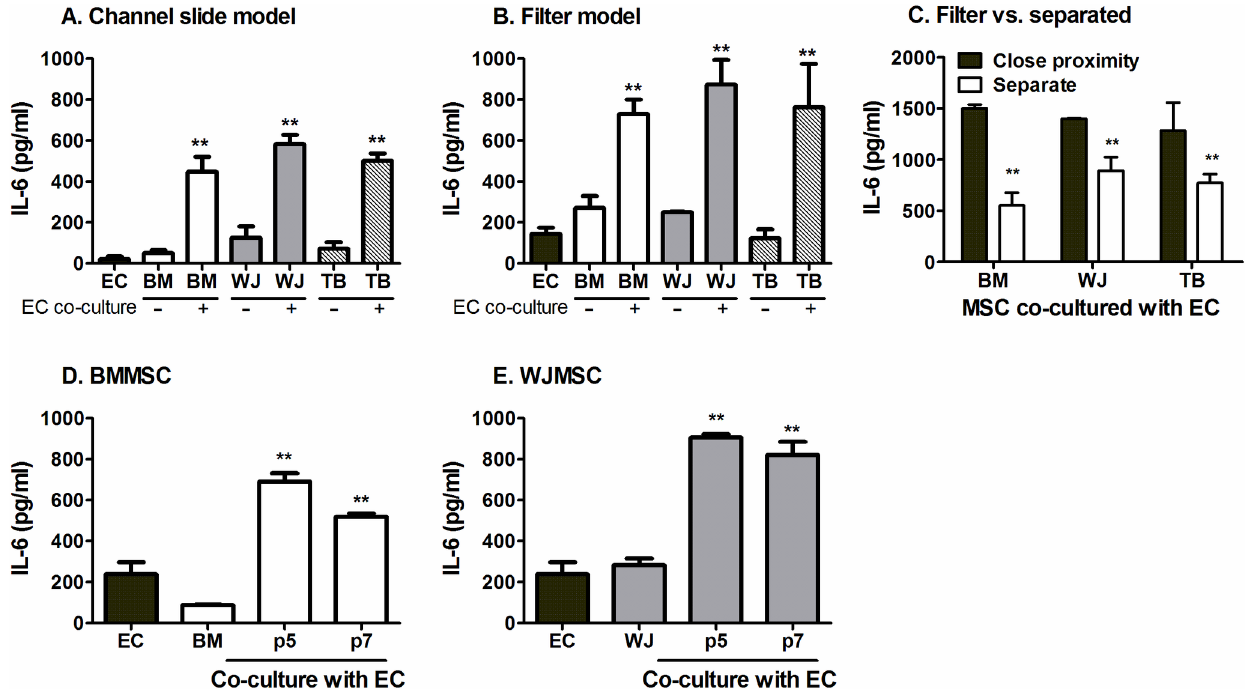
Fig 8. Effects of co-culture, of proximity between MSC and EC and MSC passage on IL-6 secretion. MSC-EC co-cultures were formed (A) in direct contact using channel slides; (B, D-E) in close proximity on opposite sides of a porous filter; or (C) in close proximity or with MSC seeded below and separate from EC on the filter above. EC and MSC mono-cultures (at p3 for WJMSC and p5 for BMMSC) were set up as controls. IL-6 release into supernatants was assessed after 24h. In (D) and (E), ANOVA showed a significant effect of culture conditions, p < 0.01. Data are mean ± SEM from (A) n = 4 – 8 (B) n = 3 – 19 where EC mono-cultures (n = 19); BMMSC mono-cultures (n = 13); EC:BMMSC (n = 16); WJMSC mono-cultures (n = 3); EC:WJMSC (n = 10); TBMSC mono-cultures (n = 4); EC:TBMSC (n = 7), (C-E) n = 3 independent experiments using a different EC and neutrophil donor in each experiment. (A-E) 5 different BMMSC, 3 different WJMSC and 3 different TBMSC donors were used. ** = p < 0.01 compared to the sum of the EC and respective MSC mono-cultures supernatant unless otherwise indicated by paired t-test in A-C, or by Dunnett post-test in